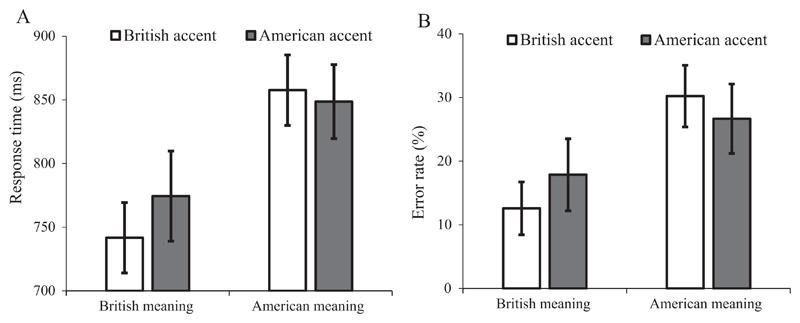
Response times (A) and error rates (B) in Experiment 4. Error bars show ±1 SE, adjusted to show within-participant effects of probe meaning (Morey, 2008).